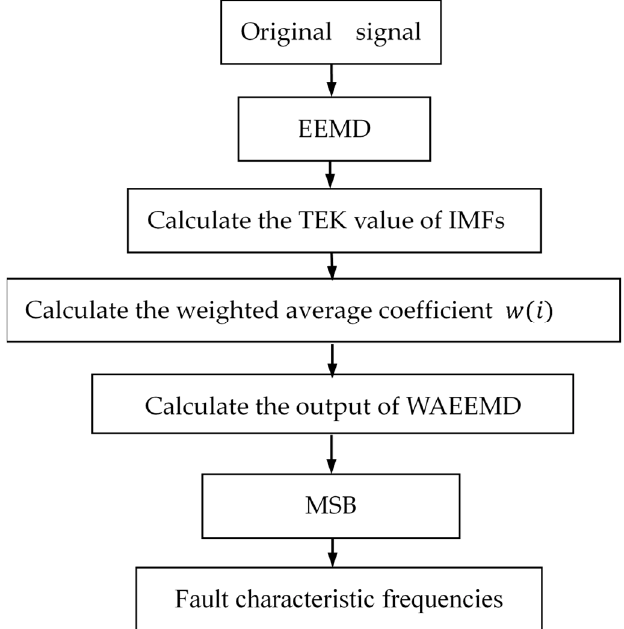
Figure 2. The flowchart of the weighted average ensemble empirical mode decomposition